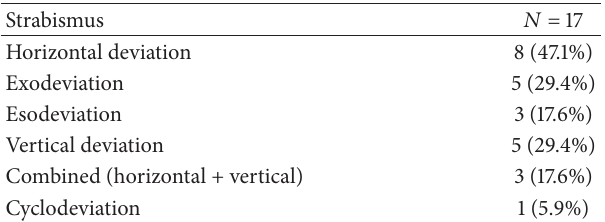
Table 2: Types of